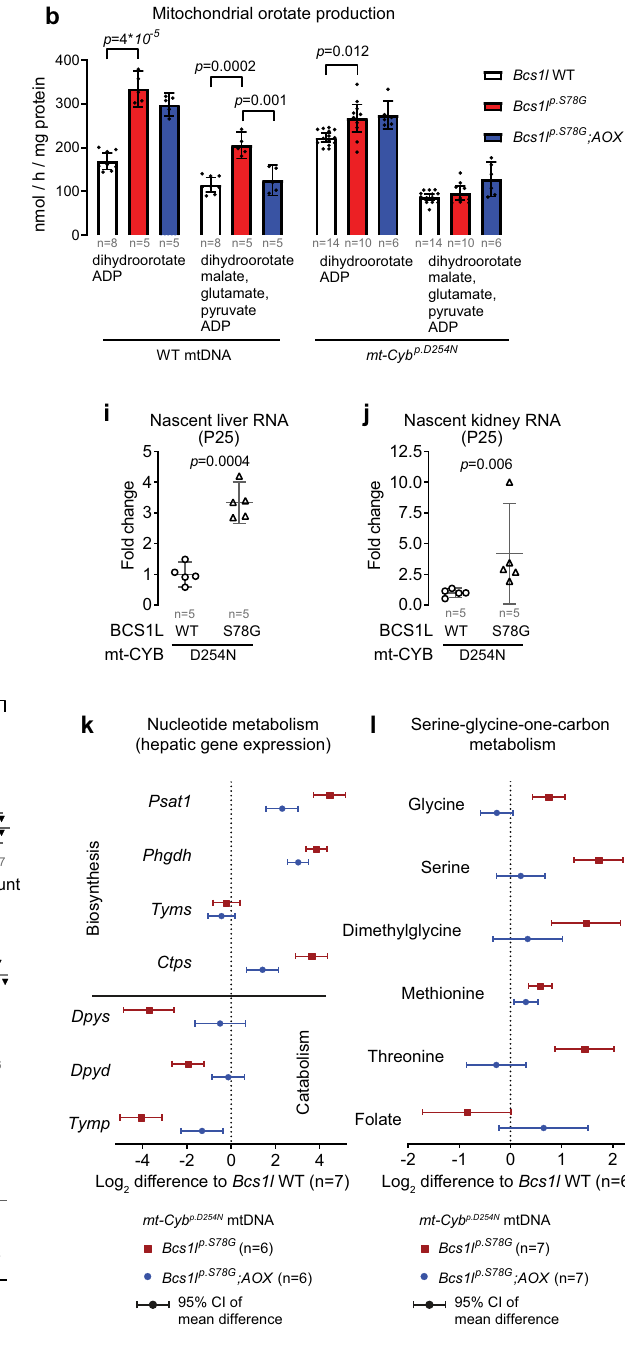
Fig. 6 | CIII de fi ciency disturbs nucleotide pools and ampli fi es transcription andnucleotidebiosynthesis.a UPLC-MSquanti fi cationofkeymetabolitesrelated toDHODHfunctioninP30livertissueof Bcs1l WT( n =6foraspartateand n =11for other metabolites), Bcs1l p.S78G ( n =7 for aspartate and n =11 for other